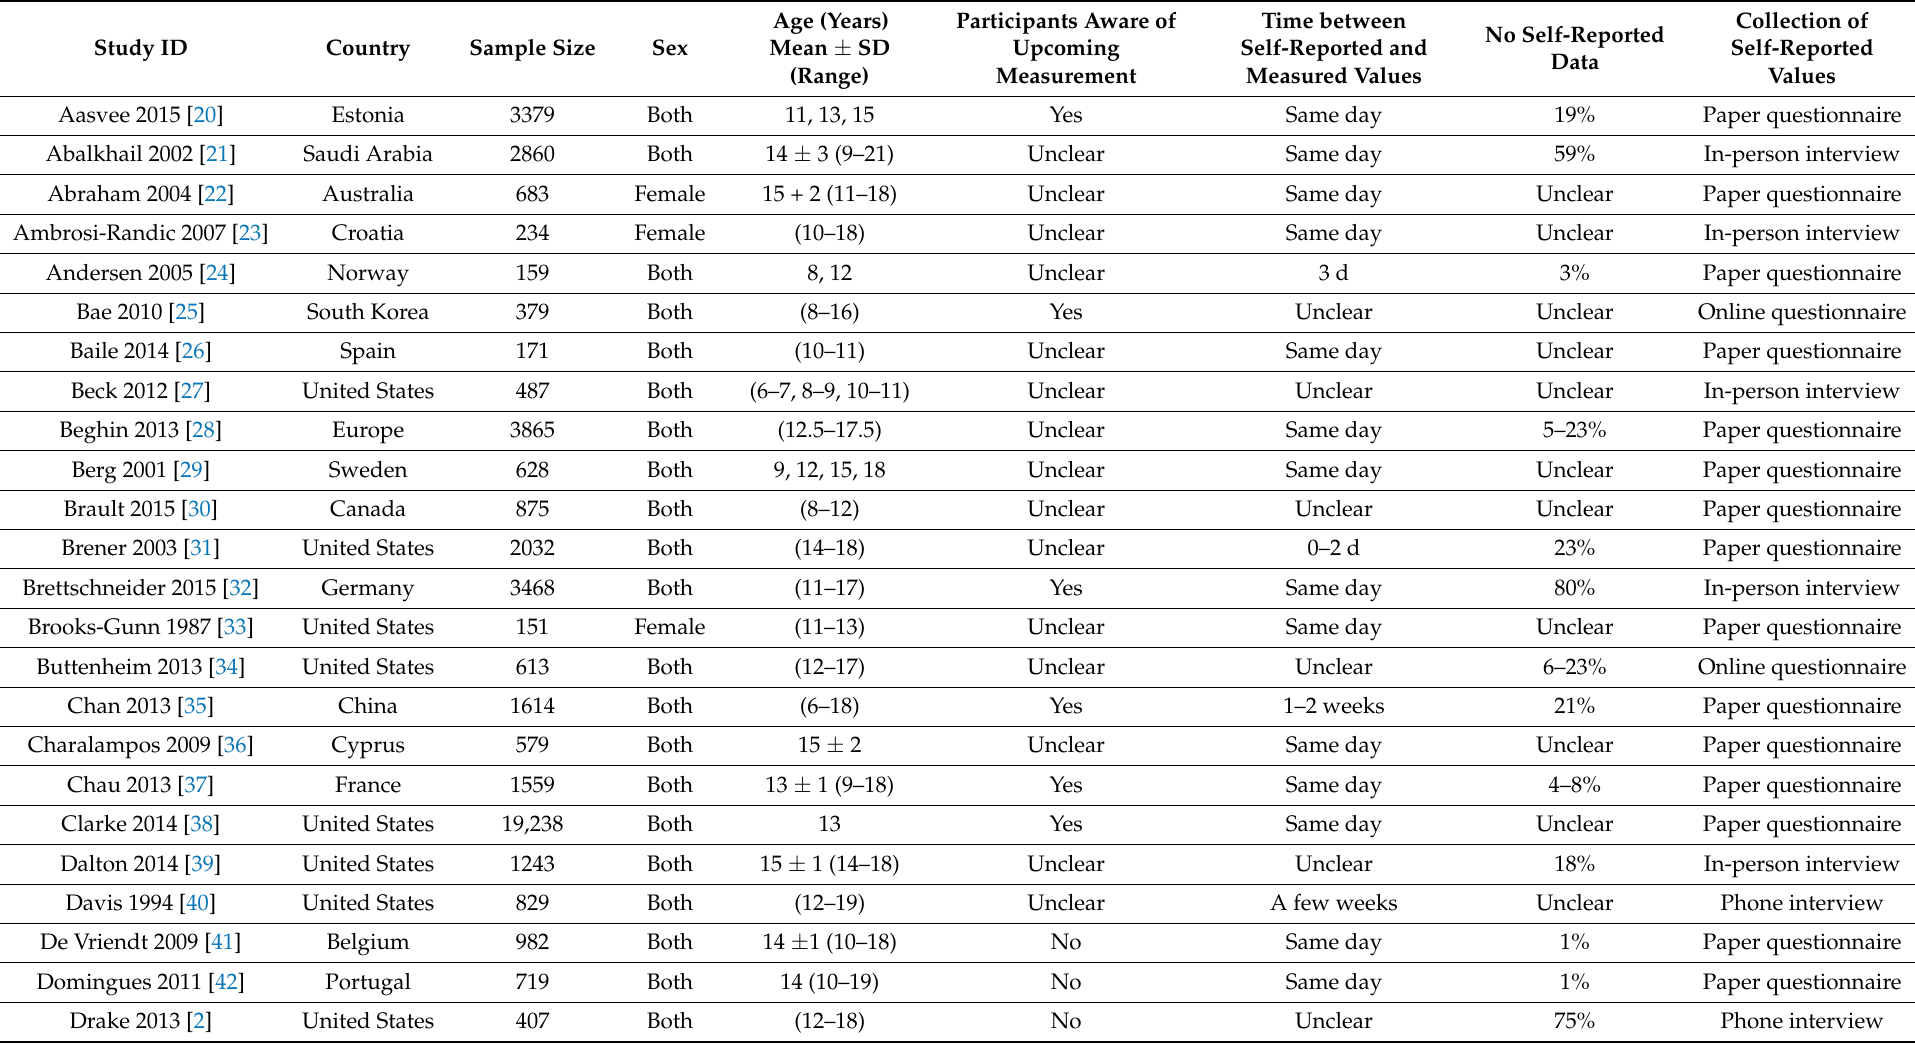
Table 4. Review of studies comparing self-reported and measured weight, height and BMI in